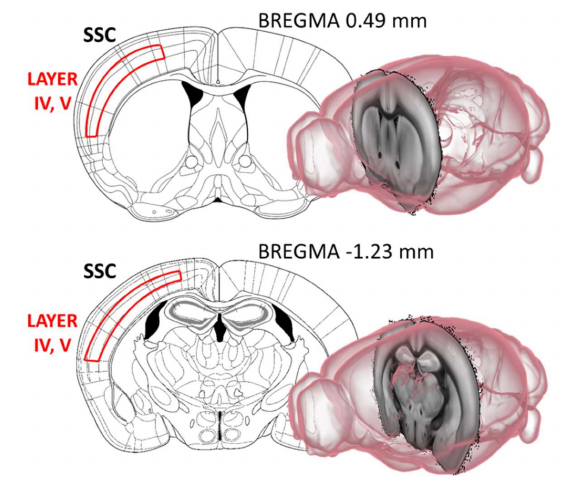
Figure 9. Acetylcholinesterase (AChE) fiber density was investigated between the 4th and 5th cortical layers of the somatosensory cortex (SSC). From each animal 6 sections from Bregma 0.49 mm to Bregma − 1.23 mm, with 120 µ m inter-sectional distance were selected and analyzed for AChE fiber density. Images were created with the help of